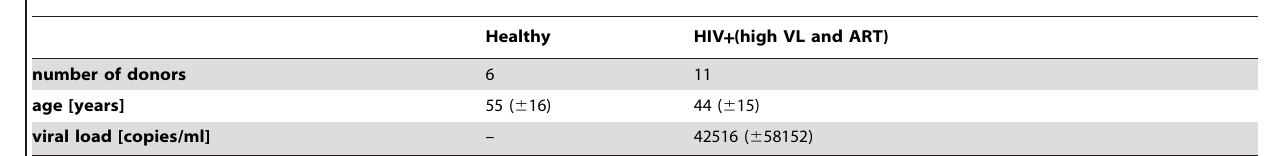
Table 2. Cohort (LNMC